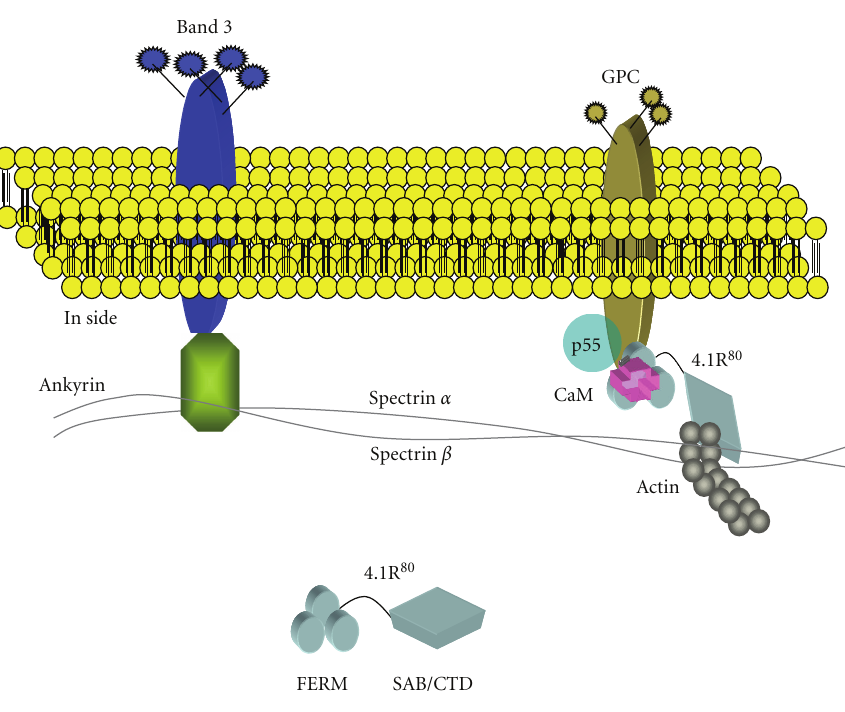
Figure 1: Structure of human erythrocyte membrane. Spectrin dimers underlying the membrane interact with transmembrane proteins band 3 through ankyrin and glycophorin C (GPC) through an actin complex and protein 4.1R 80 (4.1R 80 ). 4.1R 80 also forms a ternary complex with p55 and GPC. CaM binds to 4.1R 80 in a Ca 2+ -independent manner.